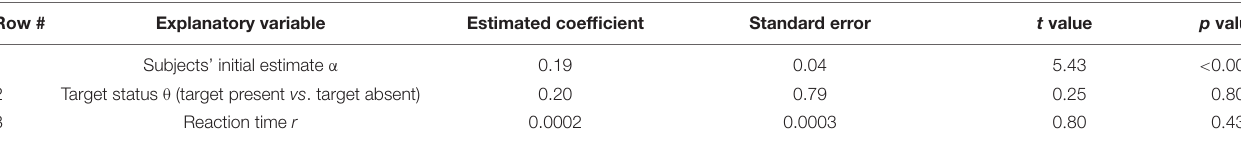
TABLE 2B | Contribution of the various explanatory variables to the size of adjustment d when anchoring information was available in Experiment 1 (Conditions 1 and